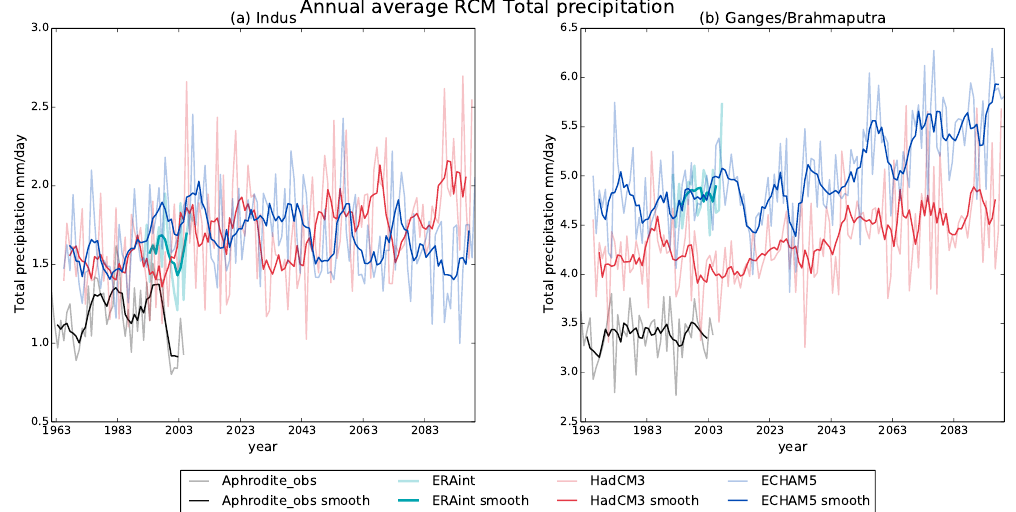
Figure 5. Annual mean total precipitation for the Indus (a) and Ganges–Brahmaputra (b) catchments for each model run (HadCM3 – red, ECHAM5 – blue, ERAint – cyan lines) plotted against APHRODITE observations (black line). Paler observations are annual averages and darker lines are a 5-year rolling smoothed